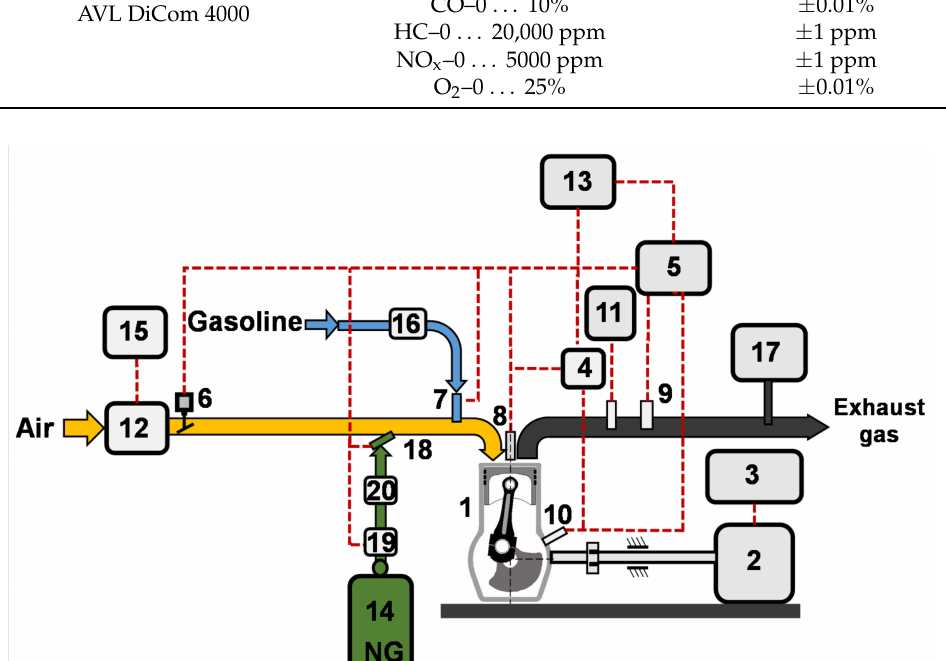
Figure 1. SI engine NISSAN HR16DE test scheme: 1—engine; 2—load stand AMX200/100;